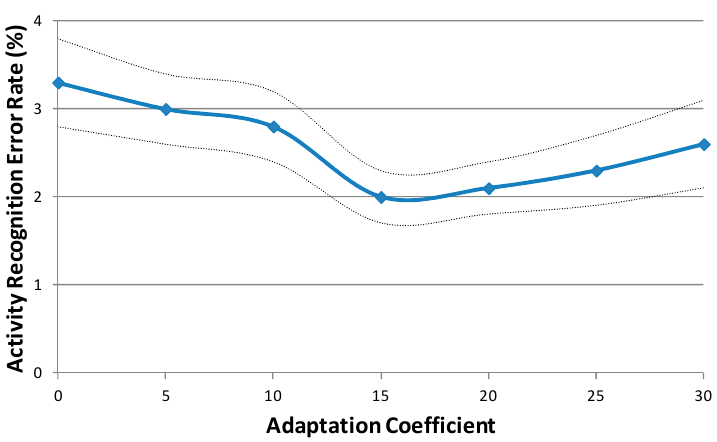
Figure 6. Activity recognition error depending on the adaptation coefficient.